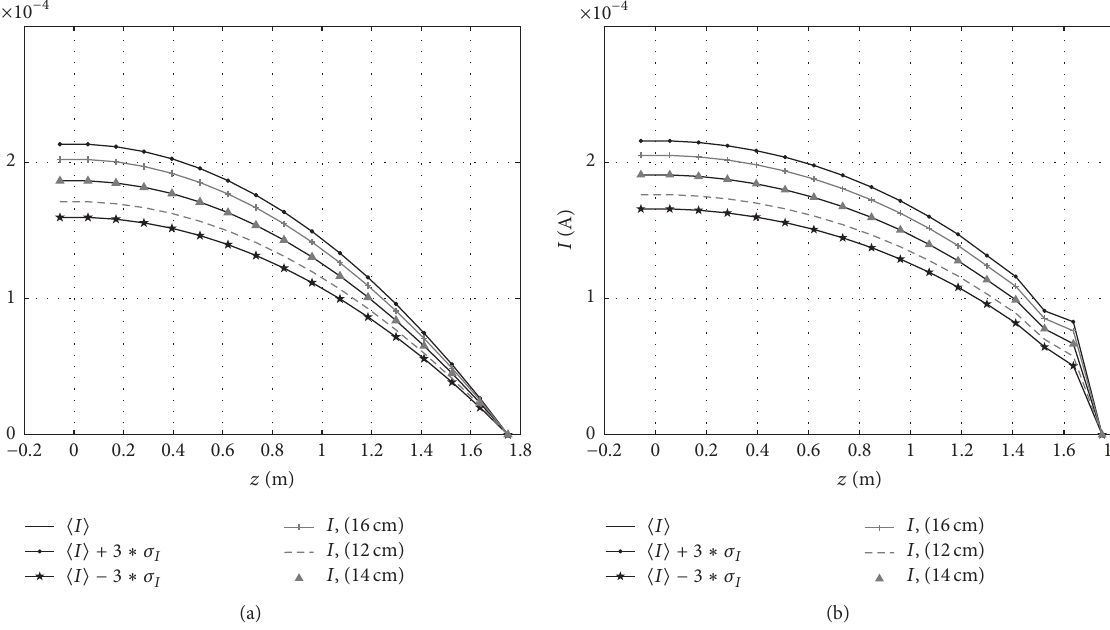
Figure 4: Induced axial current in the human body with radius 𝑎 as RV: ⟨𝐼⟩ is stochastic expected value, 𝜎 𝐼 is standard deviation, and 𝐼 is the value obtained from analytical (a) and numerical deterministic model